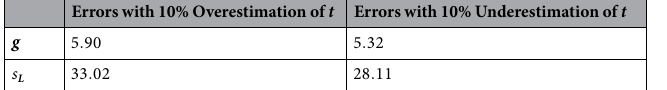
Table 2. Summary of prediction errors while enforcing 10% error in thickness: The scaled RMSE’s (see Eq. 2) are calculated for the 100 test points while enforcing 10% difference between the sample thickness used in the simulations and the thickness used in the inverse optimization.